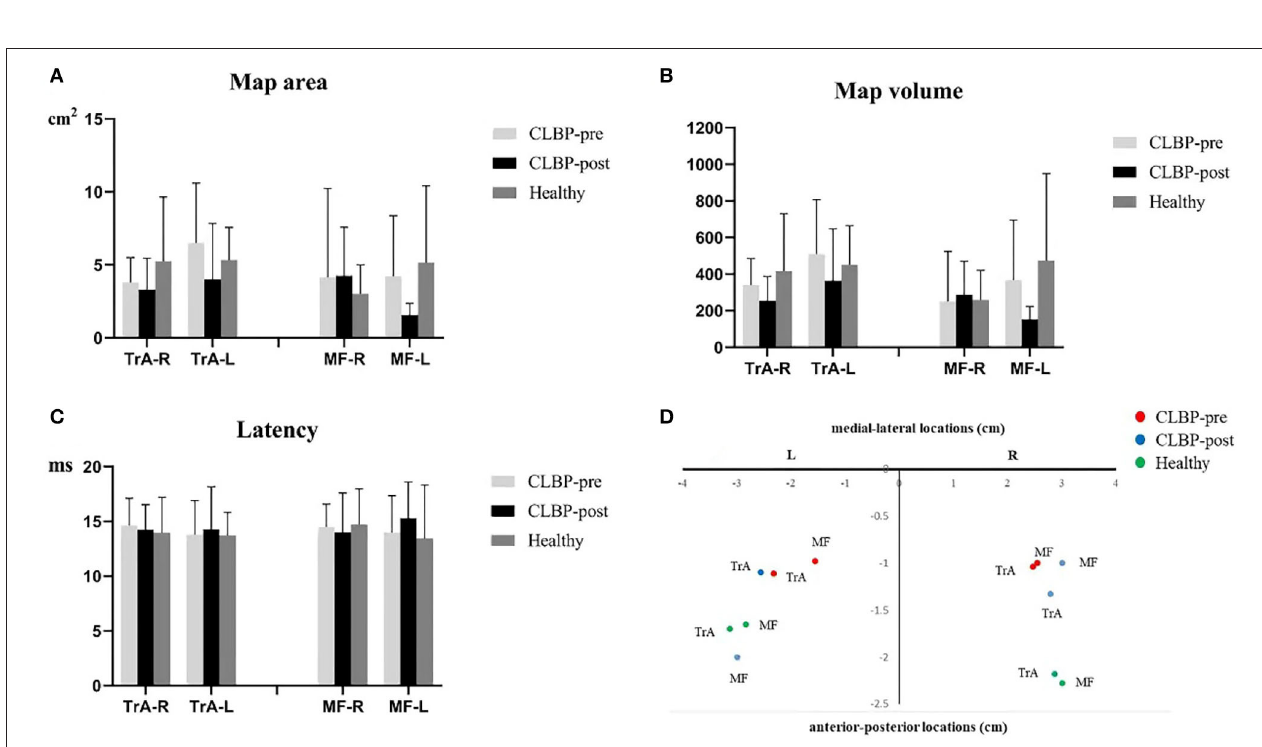
FIGURE 4 | (A–C) . Map area, map volume, and latency of the TrA and MF MEP responses to TMS for the healthy and the CLBP groups on the left and right hemispheres. (D) . The relationship between TrA and MF in the left and right hemispheres of the CLBP-pre, CLBP-post, and healthy groups. The red solid dots denote the CoGs of the muscles in the CLBP-pre group, the blue solid dots denote the CoGs of the muscles in the CLBP-post group, and the green solid dots denote the CoGs of the muscles in the healthy group. CLBP, chronic low back pain; L, left; R, right; TrA, Transversus abdominis; MF, Multifidus; CoG, center of gravity.